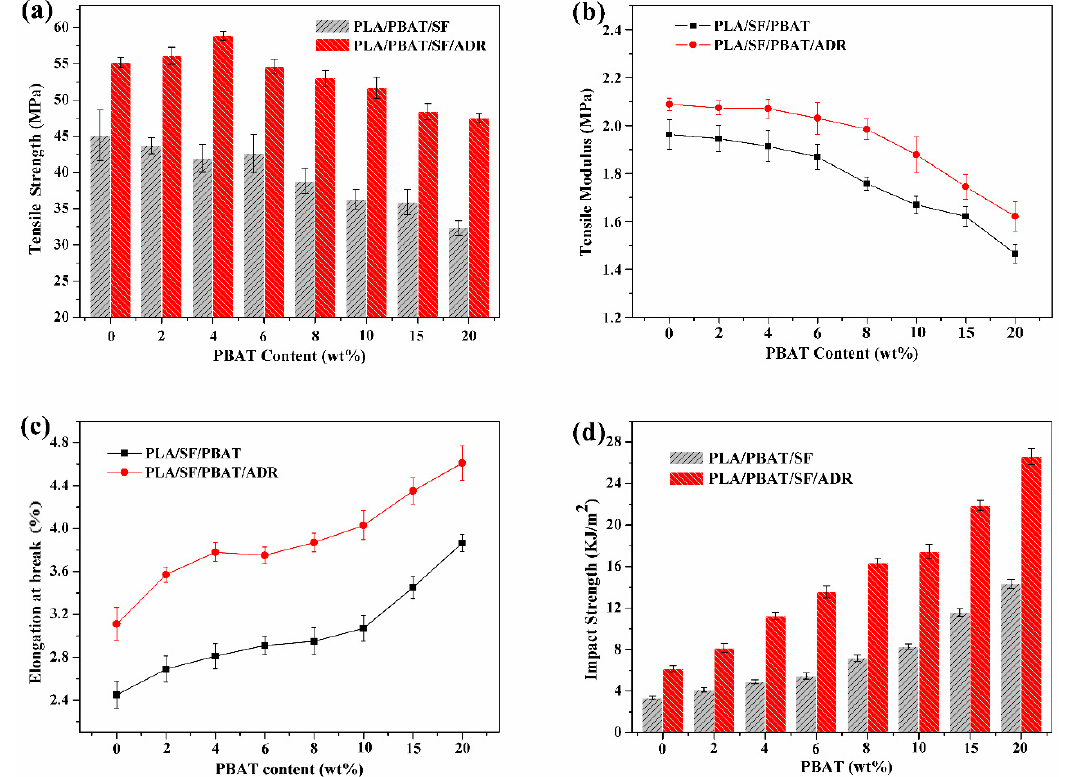
Figure 8. Tensile strength ( a ), tensile modulus ( b ), elongation at break ( c ), and impact strength ( d ) of PLA/PBAT/SF, and PLA/PBAT/SF/ADR composites.